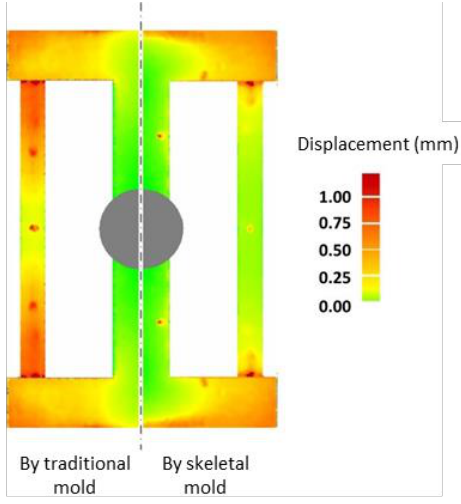
Figure 32. Comparison of deformation of the casting with traditional and skeletal sand molds.